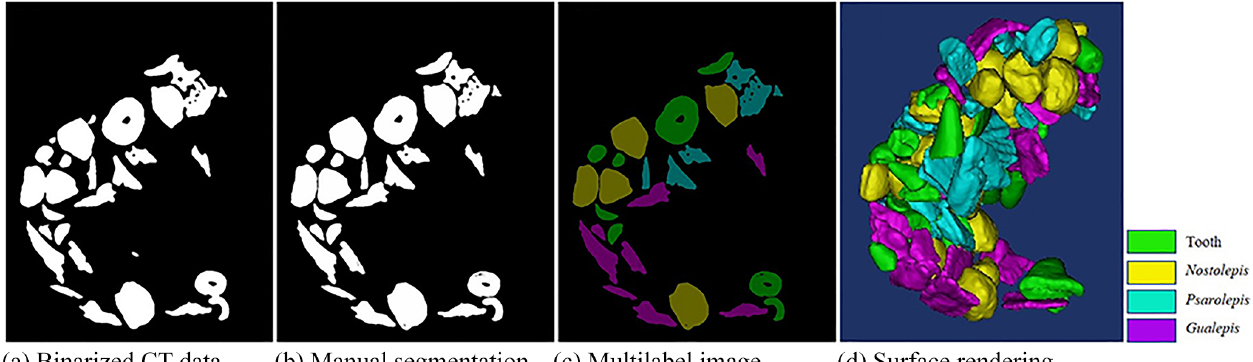
Figure 2. Reconstructing the 3D structure of fish